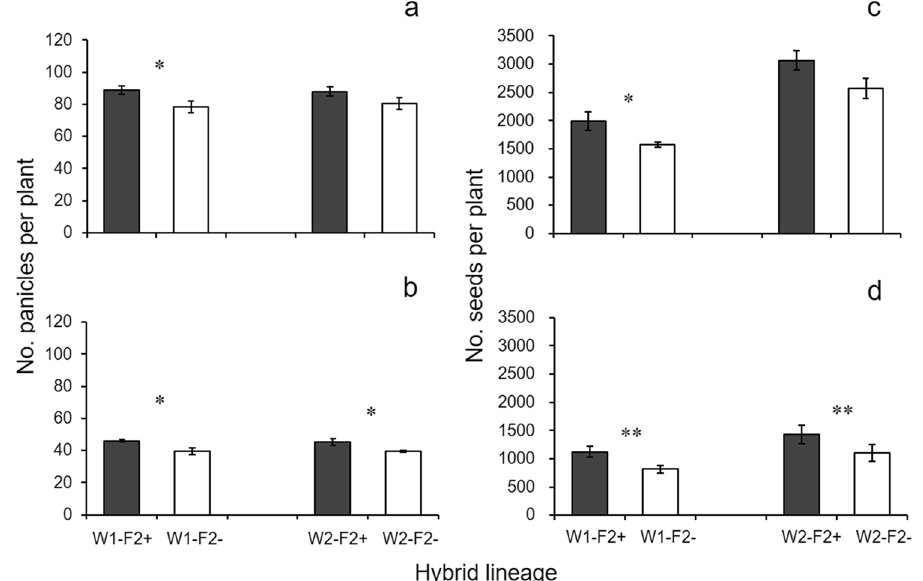
Figure 3. Number of panicles ( a , b ) and filled seeds ( c , d ) per plant of F 2 transgenic (dark grey columns) and non-transgenic (white columns) crop-wild hybrid lineages in pure-planting ( a , c ) and mix-planting plots ( b , d ). The comparisons were made between transgenic and non-transgenic F 2 hybrid lineages in mix planting (30 cm) based on paired t -test (N = 6). Bars represent standard error. * or ** indicates significances at the levels of P < 0.05 or P < 0.01, respectively.